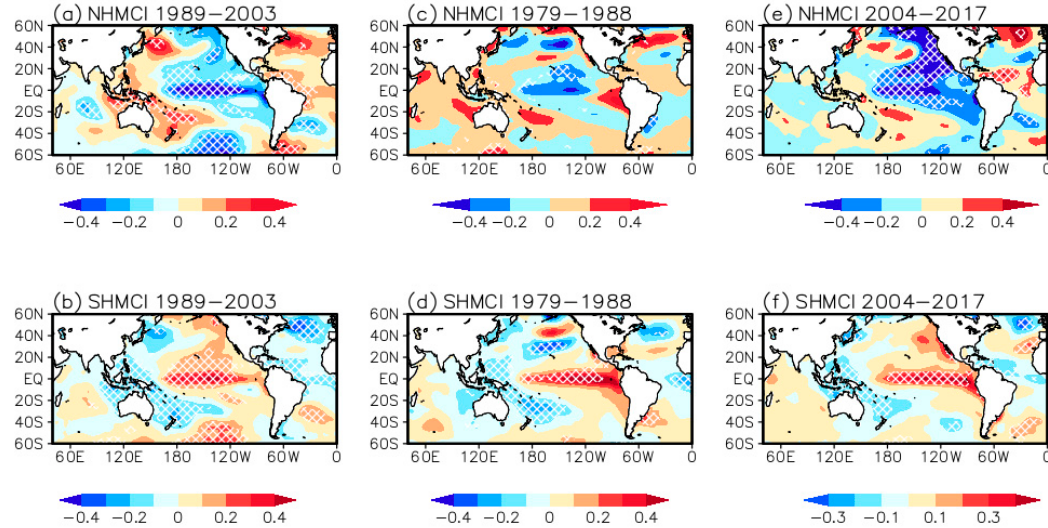
Figure 8. Linear regression maps of the NHMCI and SHMCI with the summer SST field during ( a , b ) 1989 – 2004; ( c , d ) 1979 – 1988; and ( e , f ) 2004 – 2017 (unit °C). The gridded regions represent the correlations that are positively and negatively significant at the 95% confidence level.